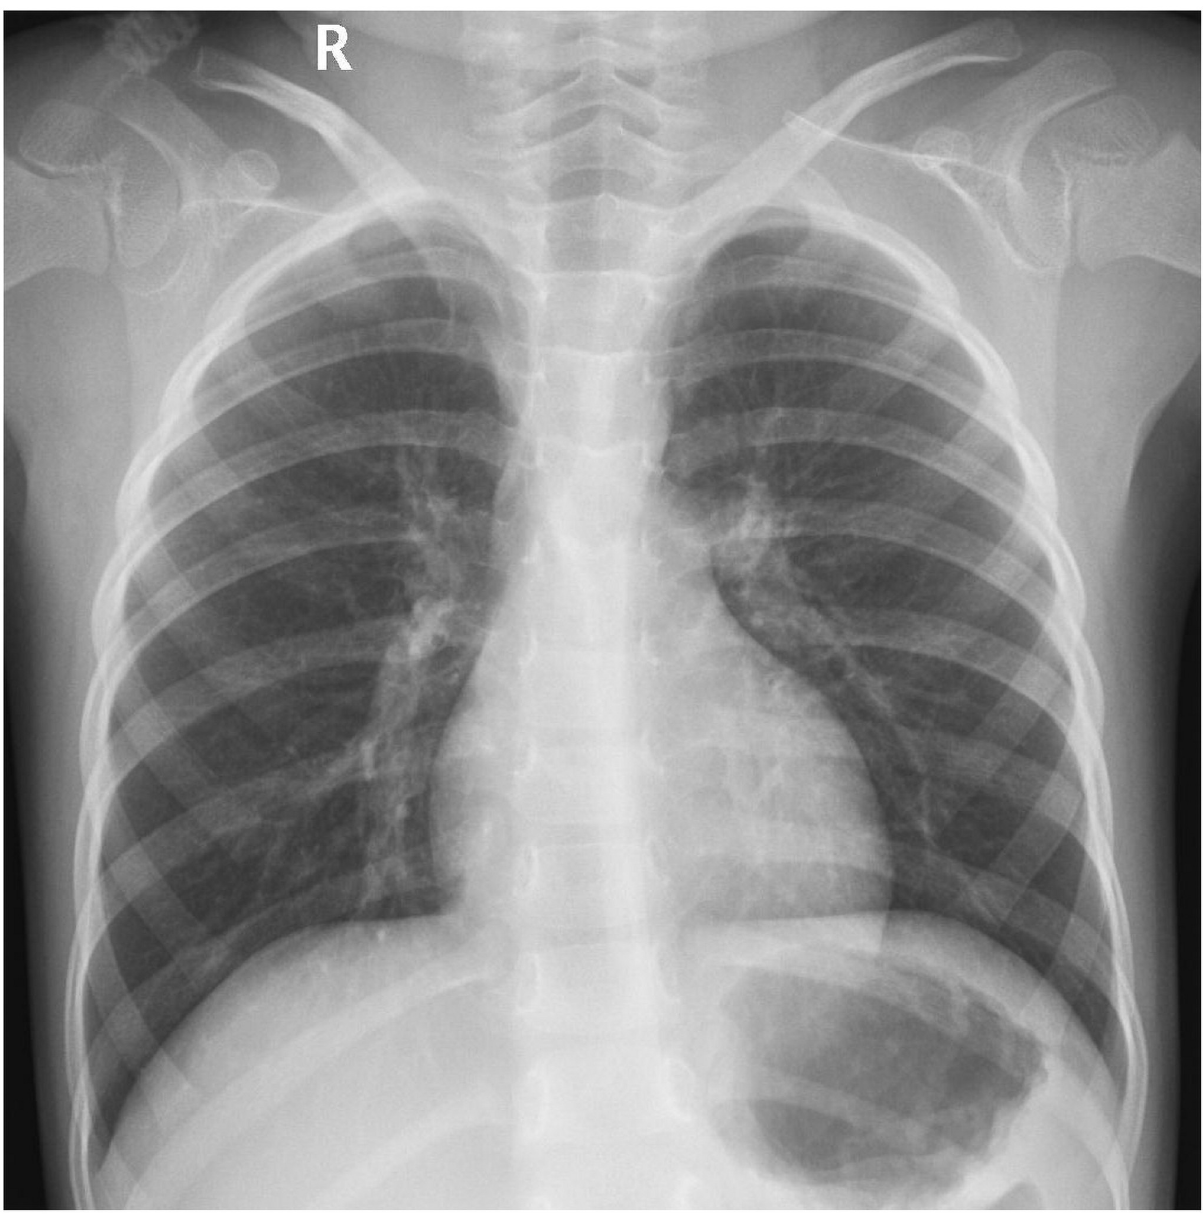
Fig 3. Chest DR image of a pediatric participant in the standing PAP group (unit A). The image shown is that of a 43-month-old male with a height of 104 cm, a weight of 15 kg, and a BMI of 13.87 kg/m 2 . The ESD value was 0.05 mGy, the DAP value was 0.13 dGy•cm 2 , the VGAS was 30, the right LFA was 76.57 cm 2 , the left LFA was 65.20 cm 2 , the total LFA was 141.77 cm 2 , and the LD was 12.36